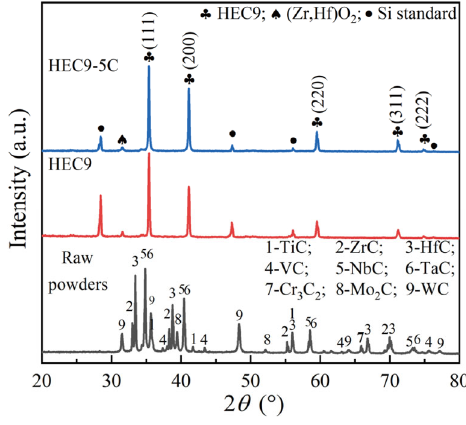
Fig. 1 XRD patterns of the mixed raw powders and sintered HEC9 and HEC9-5C